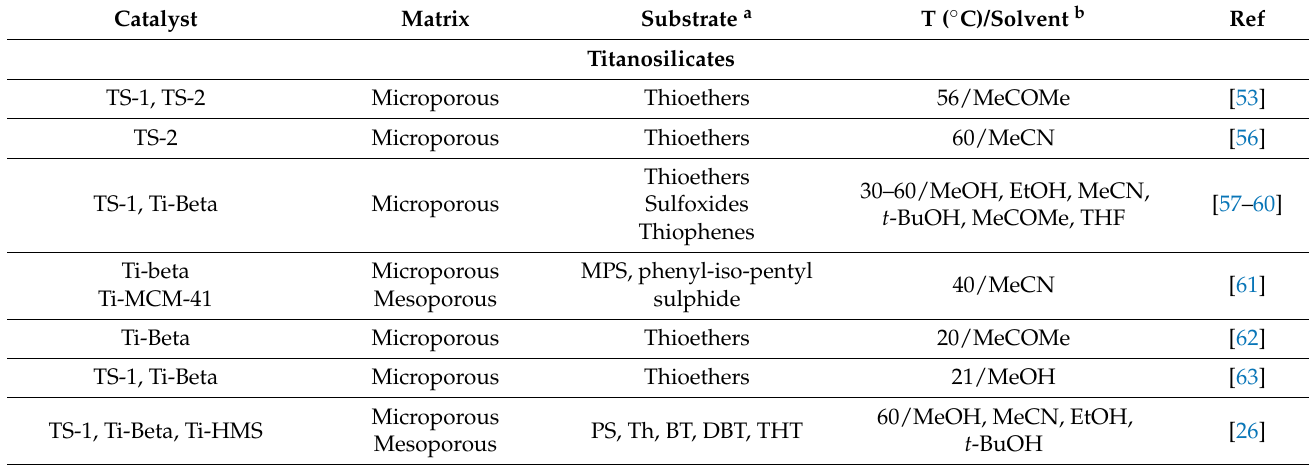
Table 3. Catalytic sulfoxidation with H 2 O 2 : main catalytic systems and reaction